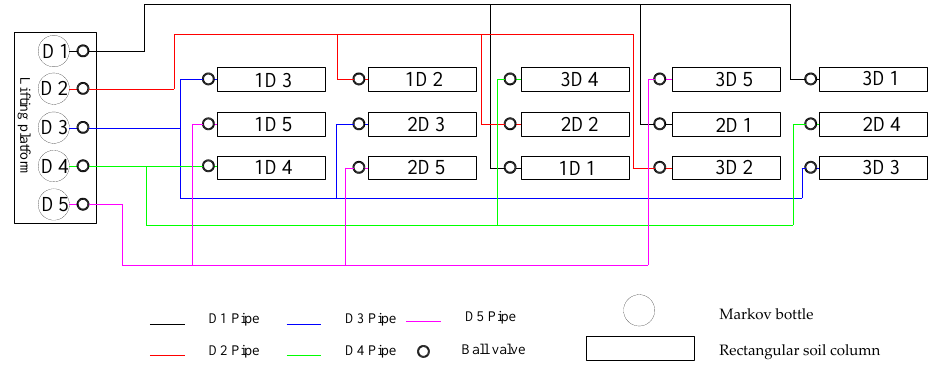
Figure 1. The layout of the SDI (subsurface drip irrigation) system.